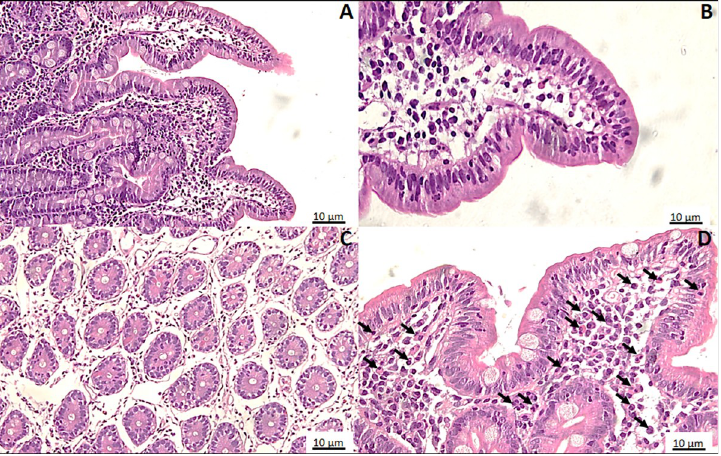
Fig 4. H &E photomicrographs of duodenal biopsies. ( A) Tissue obtained from a child who scored 4 out of 37 on the EED severity scale, with normal goblet cell density (100x). ( B) Severe reduction in the goblet cells in a blunted villous of a child with a score of 12 (400x). ( C) loss of Paneth cells seen in the duodenal crypts (200x). ( D) Chronic inflammation characterized by polymorphonuclear leukocytes marked as black arrows (400x).